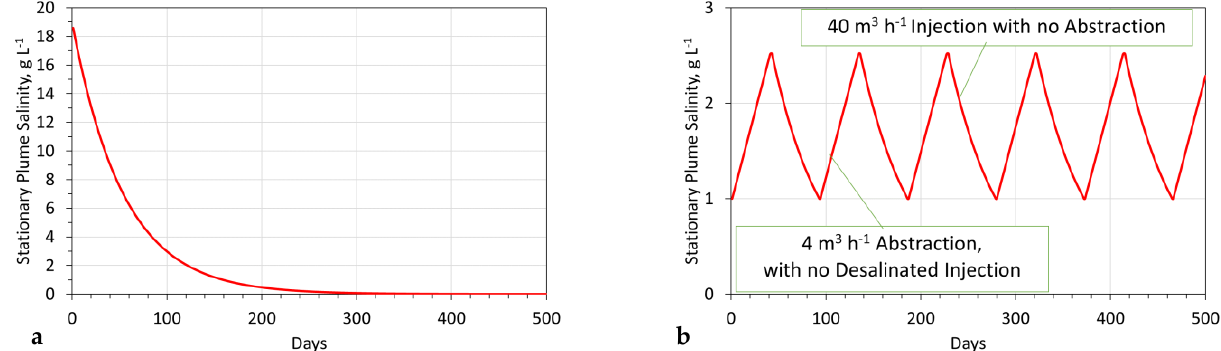
Figure A12. Modeled stationary plume. n-Fe(b)@Ca@Urea polymer catalyst: ( a ) time required to reduce the plume salinity. ( b ) Salinity of irrigation water versus time and aquifer recharge time.